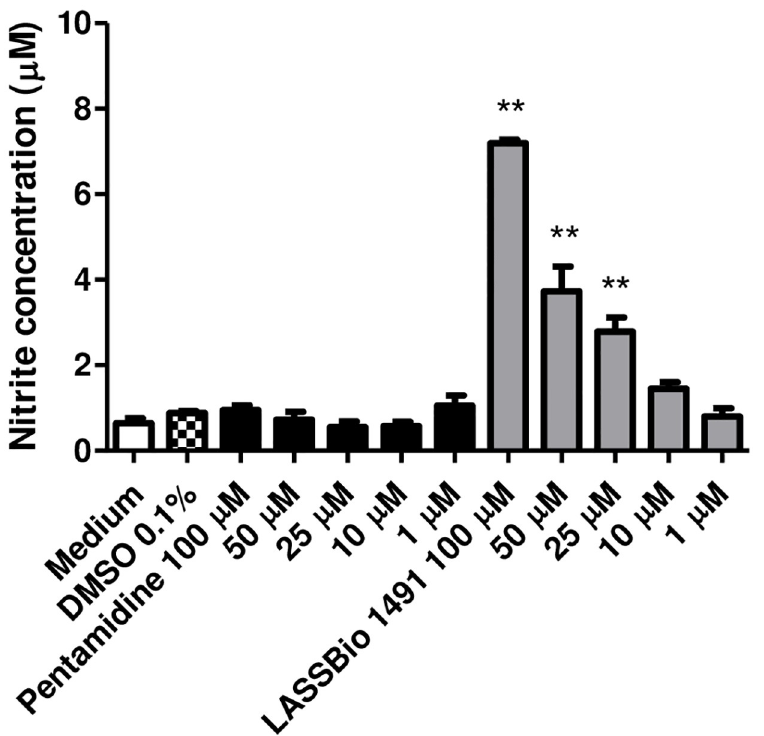
Fig 2. Concentration-dependent response to pentamidine and LASSBio-1491 in the nitrite measurement using the Griess reaction, in culture of peritoneal macrophages infected with L . major LV39.